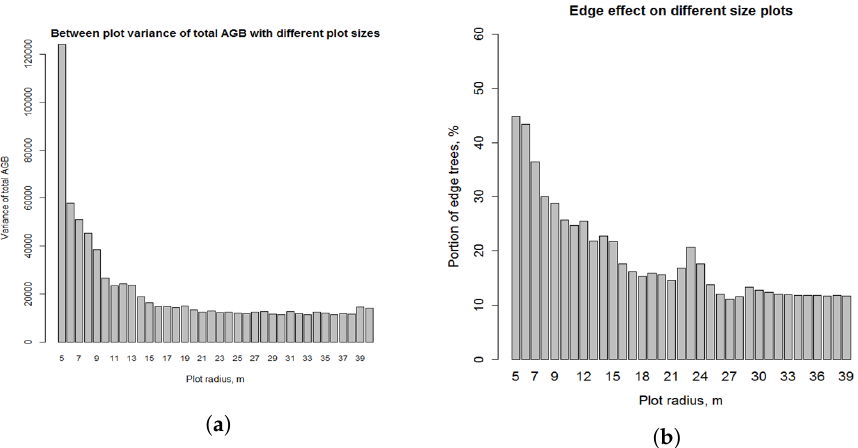
Figure 7. The effect of field plot size (5–40-m radius) on between plot variance and on number of edge trees within plots. Results with radii 5–30 m are based on 46 plots; results with radii 31–40 m are based only on 10 plots: ( a ) Between plot variance of total AGB; ( b ) Average portion of edge trees within